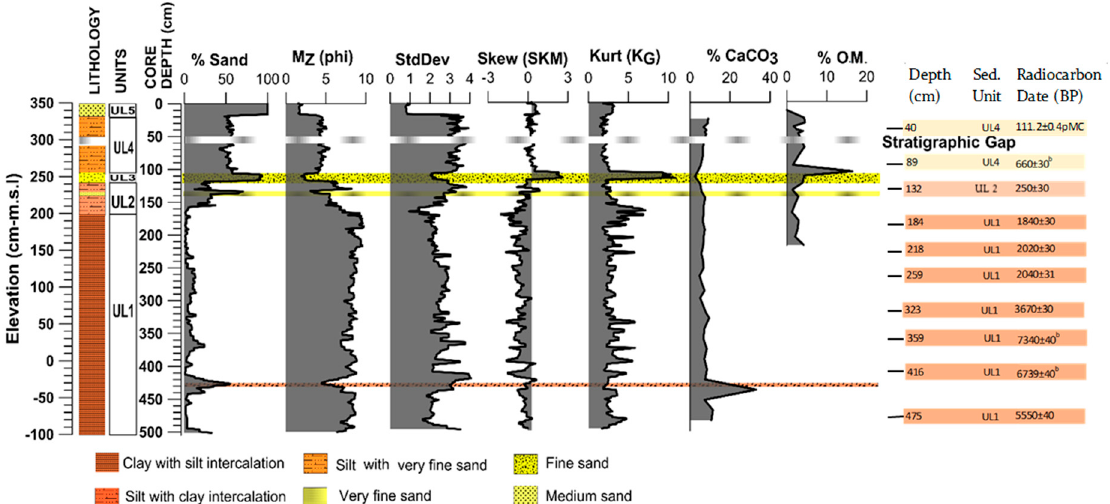
Figure 2. Lithostratigraphy of the core CF 2, the vertical variation of the main textural parameters: Mean grain size (M Z ), sorting (StdDev), skewness (Skew), and kurtosis (Kurt). The organic matter content (O.M.), calcium carbonate variation, and radiocarbon dating are also represented. The color lines represent the possibly extreme events, where the unit UL3 (the thick yellow line) was possibly deposited by the CE 1755 tsunami. The two thin lines in yellow and orange color correspond to the sandy layers (UL1a and UL2a) related to other possibly extreme events in the Alcabrichel River alluvial plain.